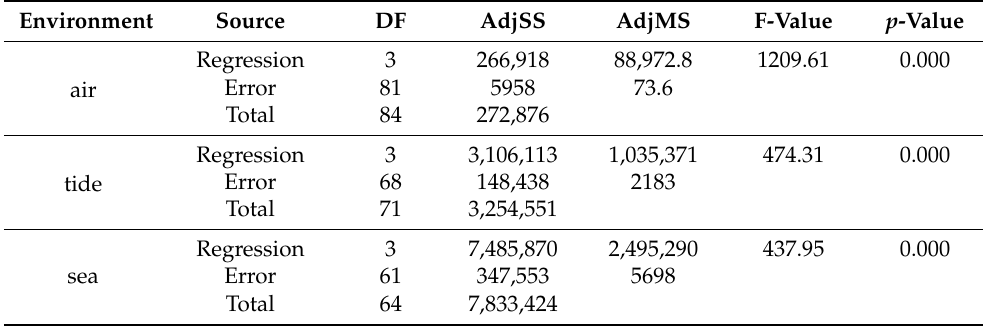
Table 7. The regression analysis of variance for the NiTi2 alloy samples for the three observed types of marine